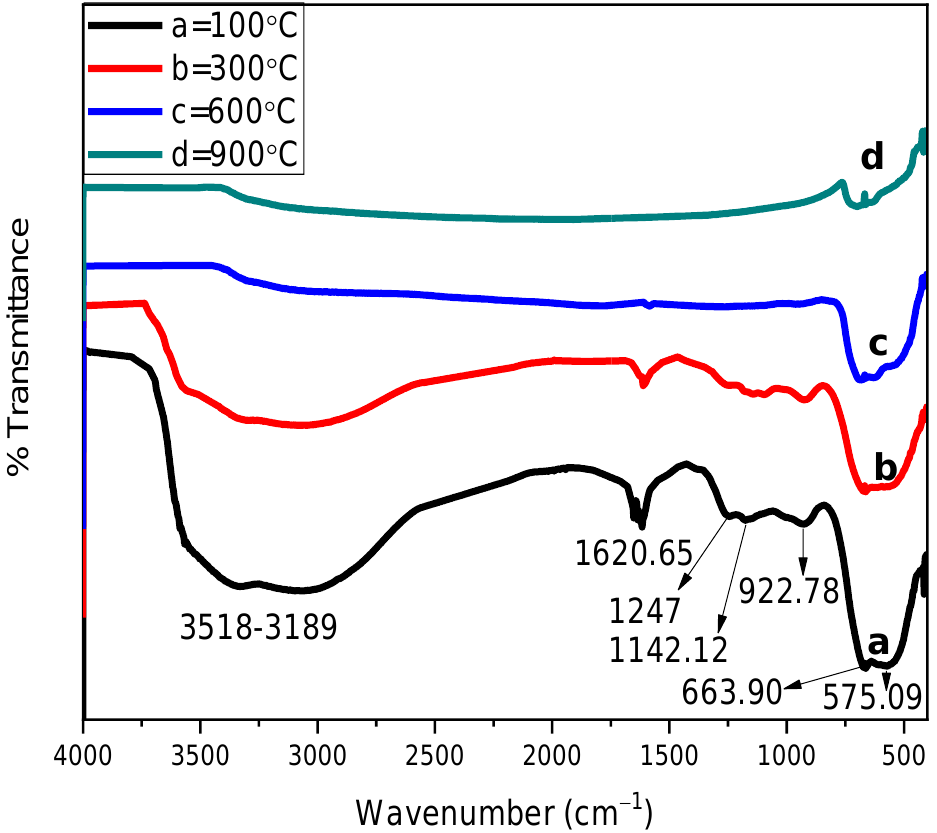
Figure 5. FTIR spectra of SnO 2 NPS calcined at different temperatures.